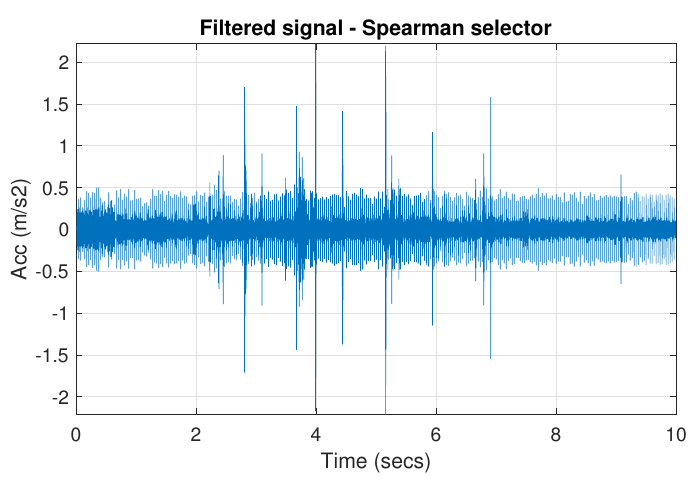
Figure 46. Filtered signal r by Spearman